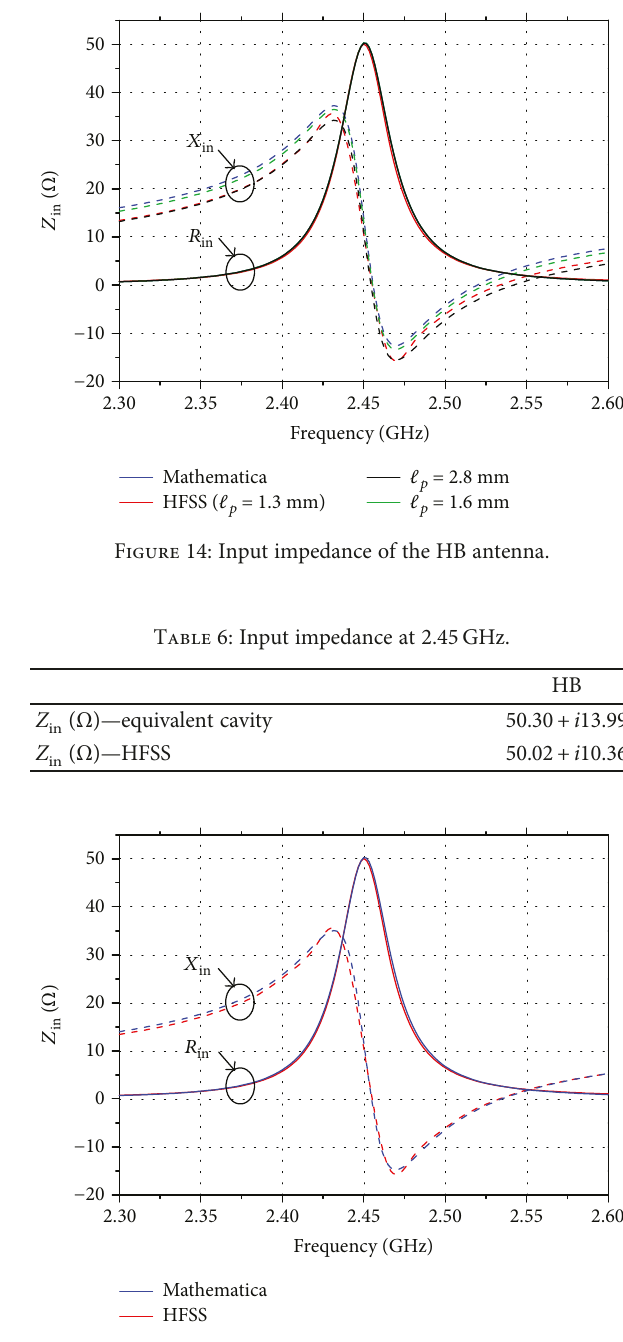
Figure 15: Input impedance of the HB antenna: ℓ